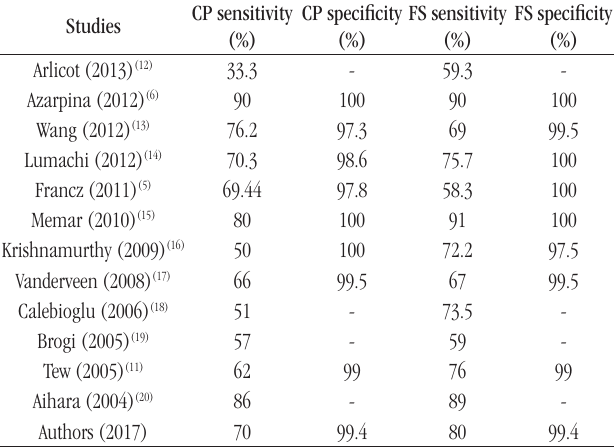
taBLE 2 − Comparison between the clinical epidemiological indexes obtained by the researched authors and from this study Studies